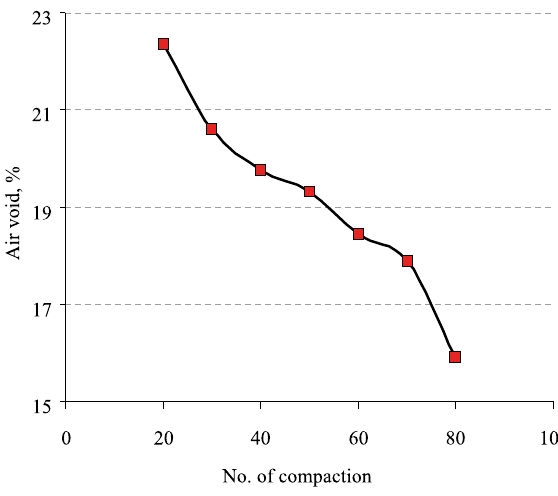
Fig. 4. Variation of air voids as the number of compaction blows